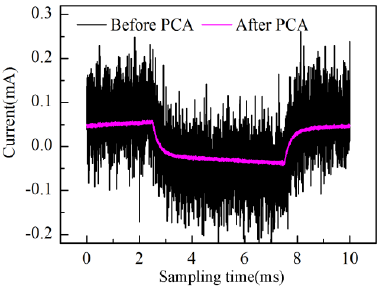
Figure 3. Current before and after PCA processing.